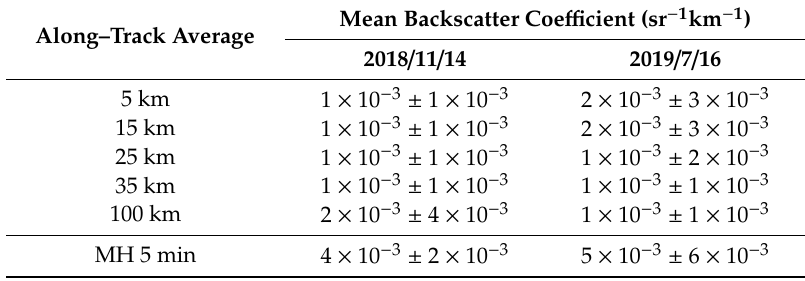
Table A1. Mean backscatter coe ffi cient values with the respective standard deviation for all CALIOP along–track averages over Mace Head. The values are related to the case studies from Section 5.1.1.